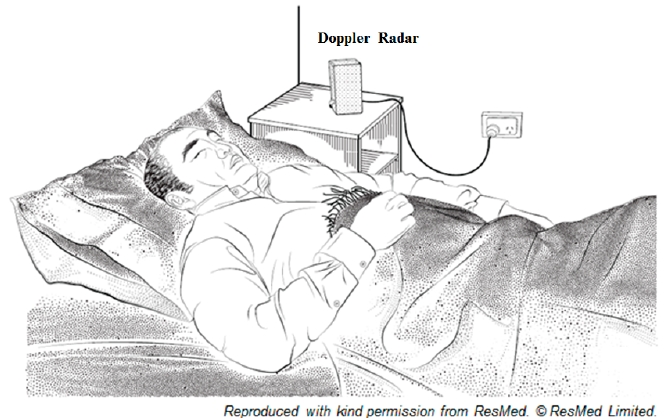
Figure 4. Non-contact Doppler radar setup in a sleep laboratory or at home.